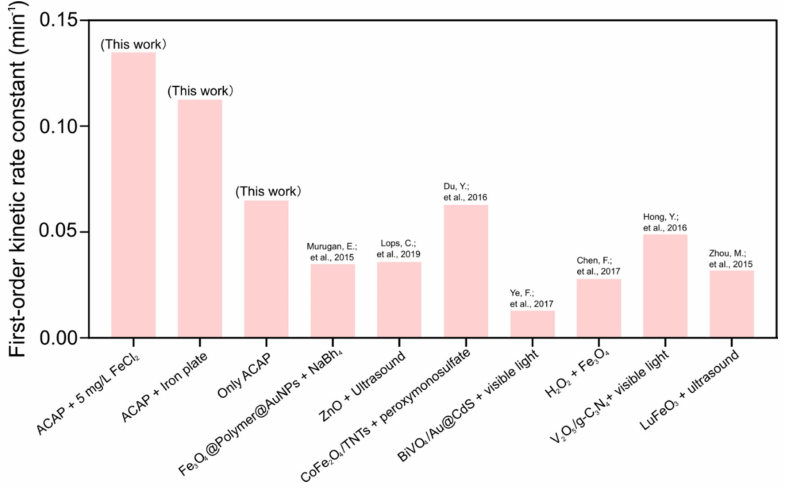
Figure 10. Comparison of the first order kinetics rate constants obtained in the present and other studies of RhB decomposition